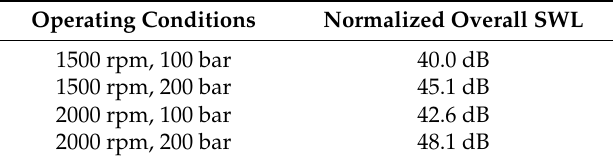
Table 3. Normalized overall sound power levels for the four different operating conditions.